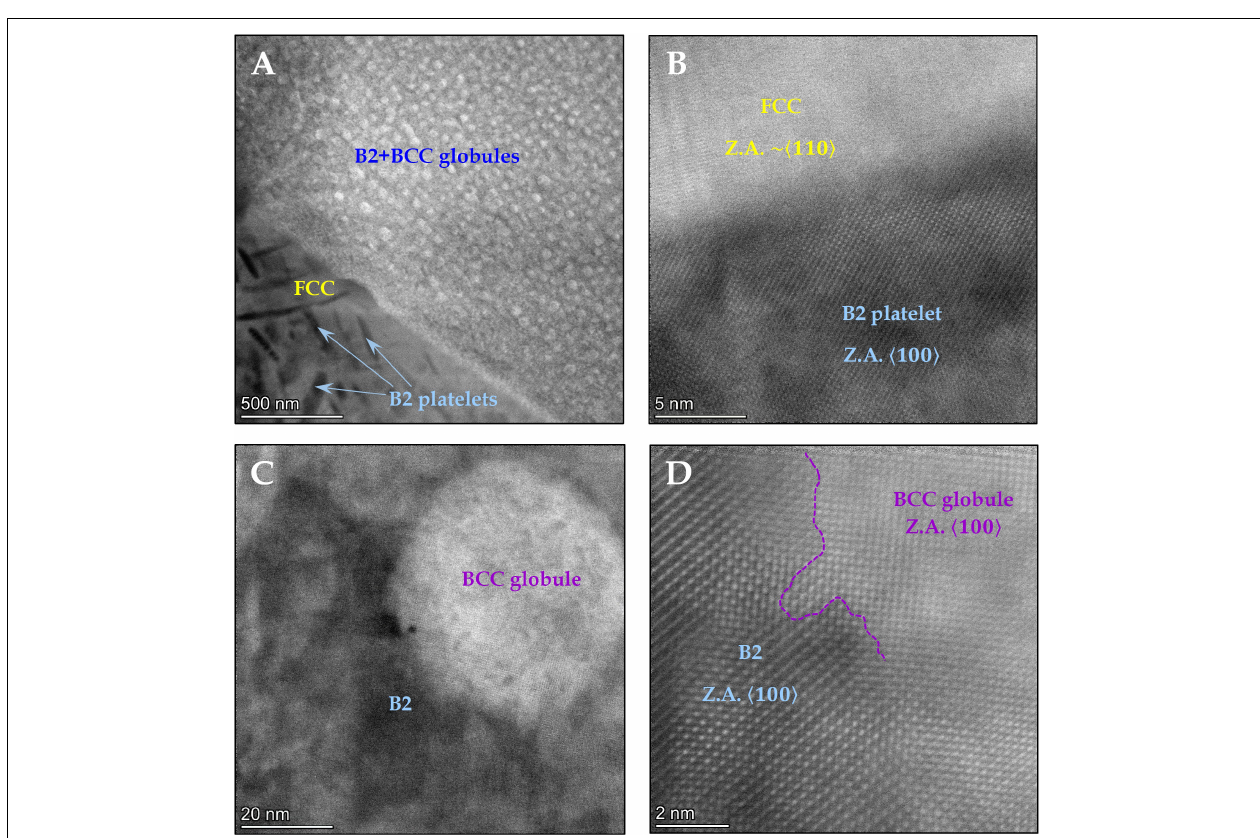
FIGURE 12 | (A) STEM image showing the extremely fine precipitates in the B2 and FCC phases characteristic of the microstructure of the homogenized and aged (750 ◦ C) AlCrFe 2 Ni 2 alloy. (B) HAADF of a B2 platelet showing a lattice image in the < 100 > zone axis, relative to the FCC parent phase whose zone axis is close to < 110 > ; (C) Low magnification HAADF of the B2+BCC domain in the < 100 > zone axis, showing the outlines of a globule; (D) HAADF image showing the interface between the ordered B2 parent phase and the BCC